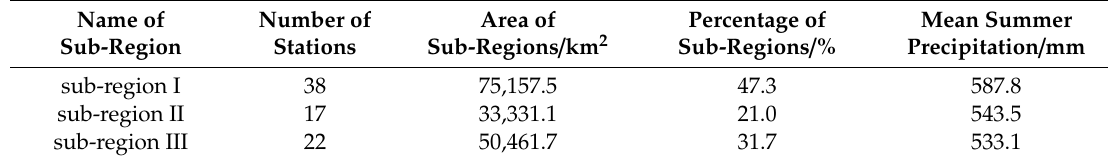
Table 2. The area and precipitation averaged over the three sub-regions.